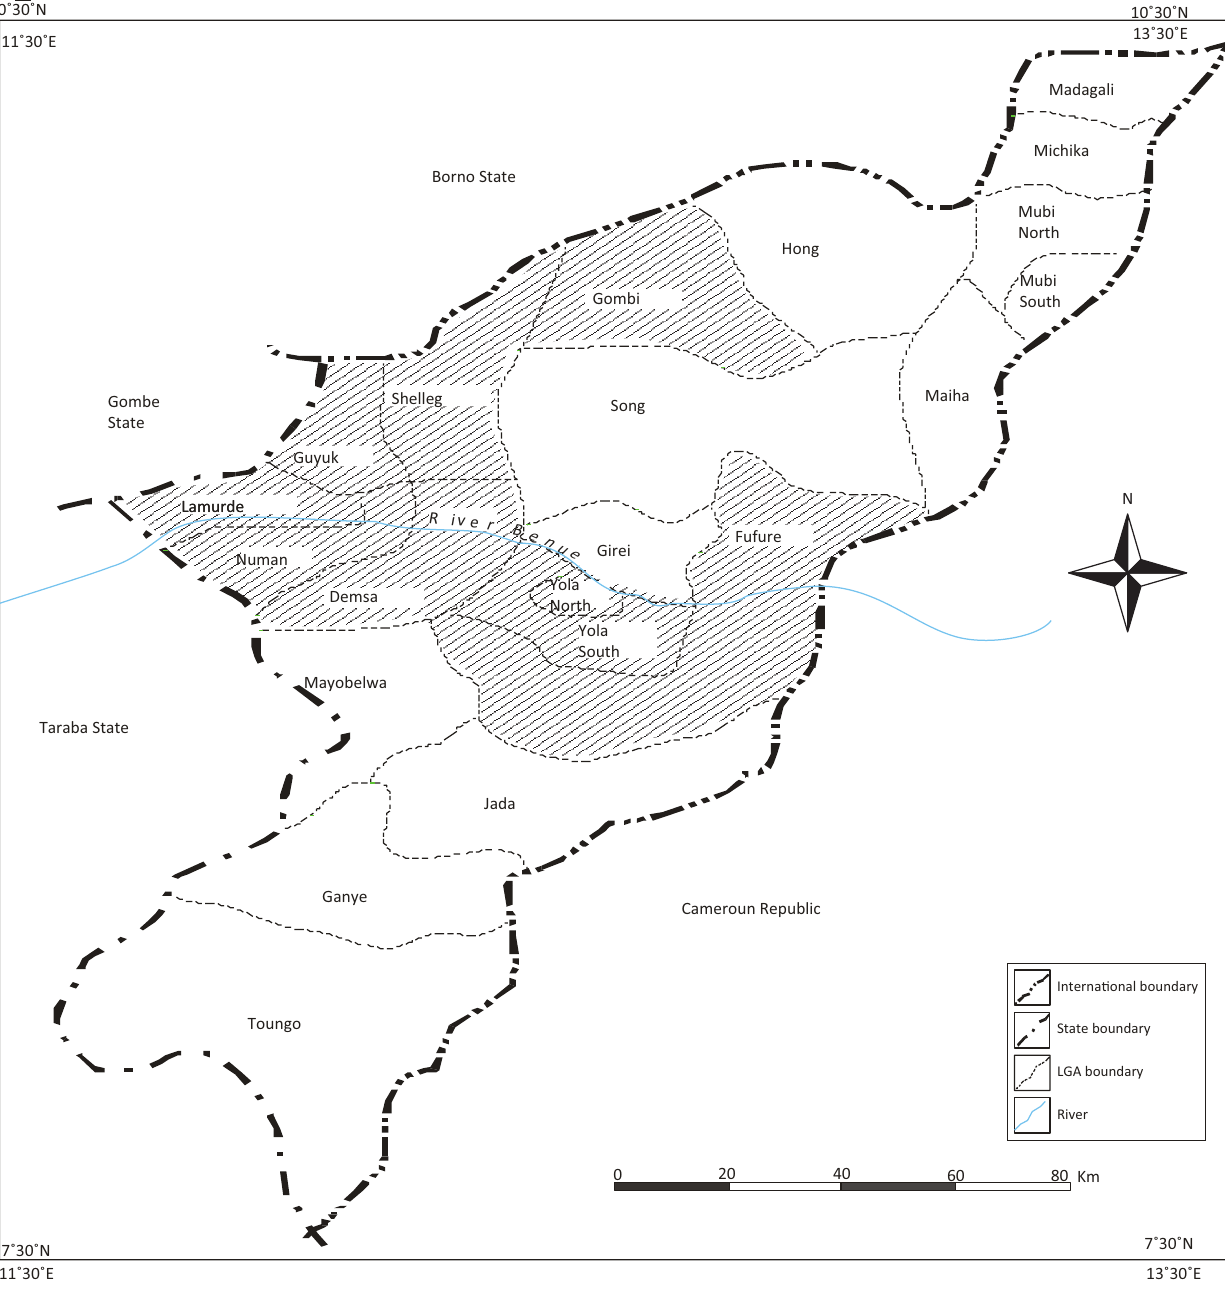
FIGURE 1: Adamawa State showing the study